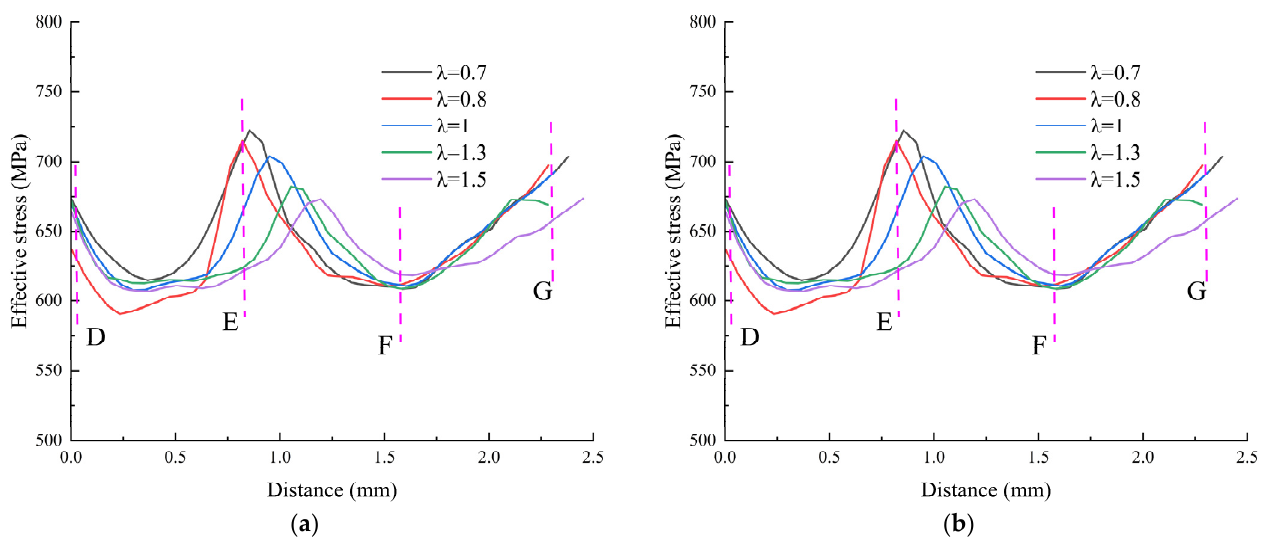
Figure 5. Variation curves of effective stress of the fins along the DEFG direction trajectory under different conditions: ( a ): RT-EM; ( b ): CT-EM